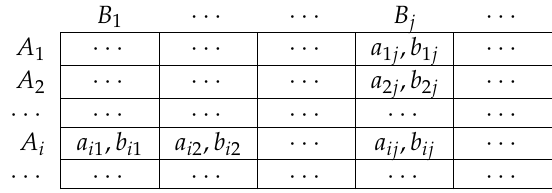
Figure 1. A general two-player